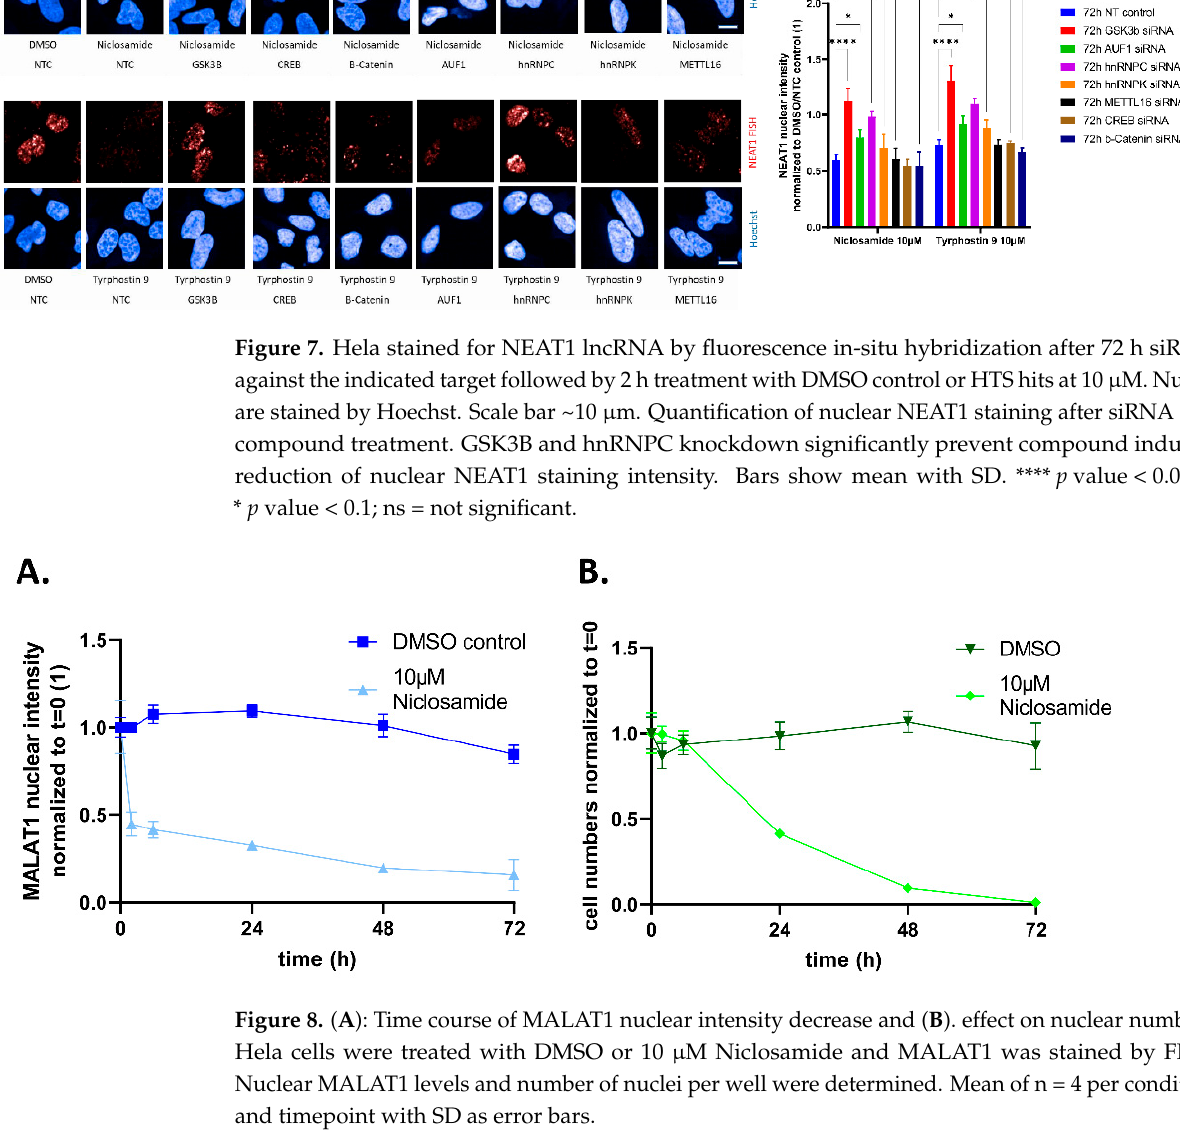
Figure 7. Hela stained for NEAT1 lncRNA by fluorescence in-situ hybridization after 72 h siRNA against the indicated target followed by 2 h treatment with DMSO control or HTS hits at 10 µM. Nuclei are stained by Hoechst. Scale bar ~10 µm. Quantification of nuclear NEAT1 staining after siRNA and compound treatment. GSK3B and hnRNPC knockdown significantly prevent com- pound induced reduction of nuclear NEAT1 staining intensity. Bars show mean with SD. **** p value < 0.0001; * p value < 0.1; NS = not significant.